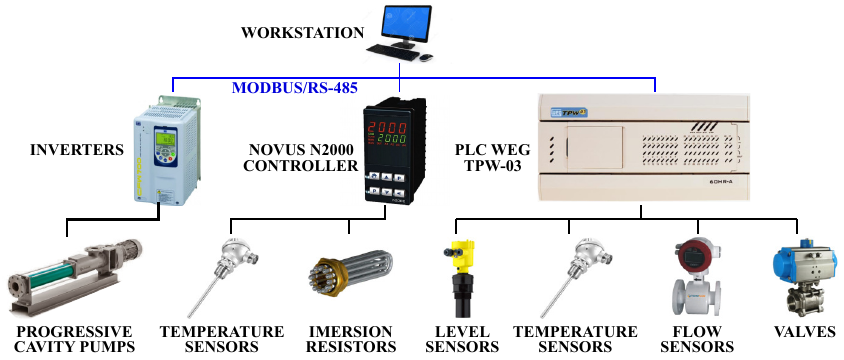
Figure 7. System architecture of the test plant.